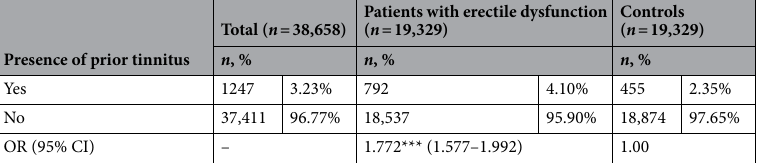
Presence of prior